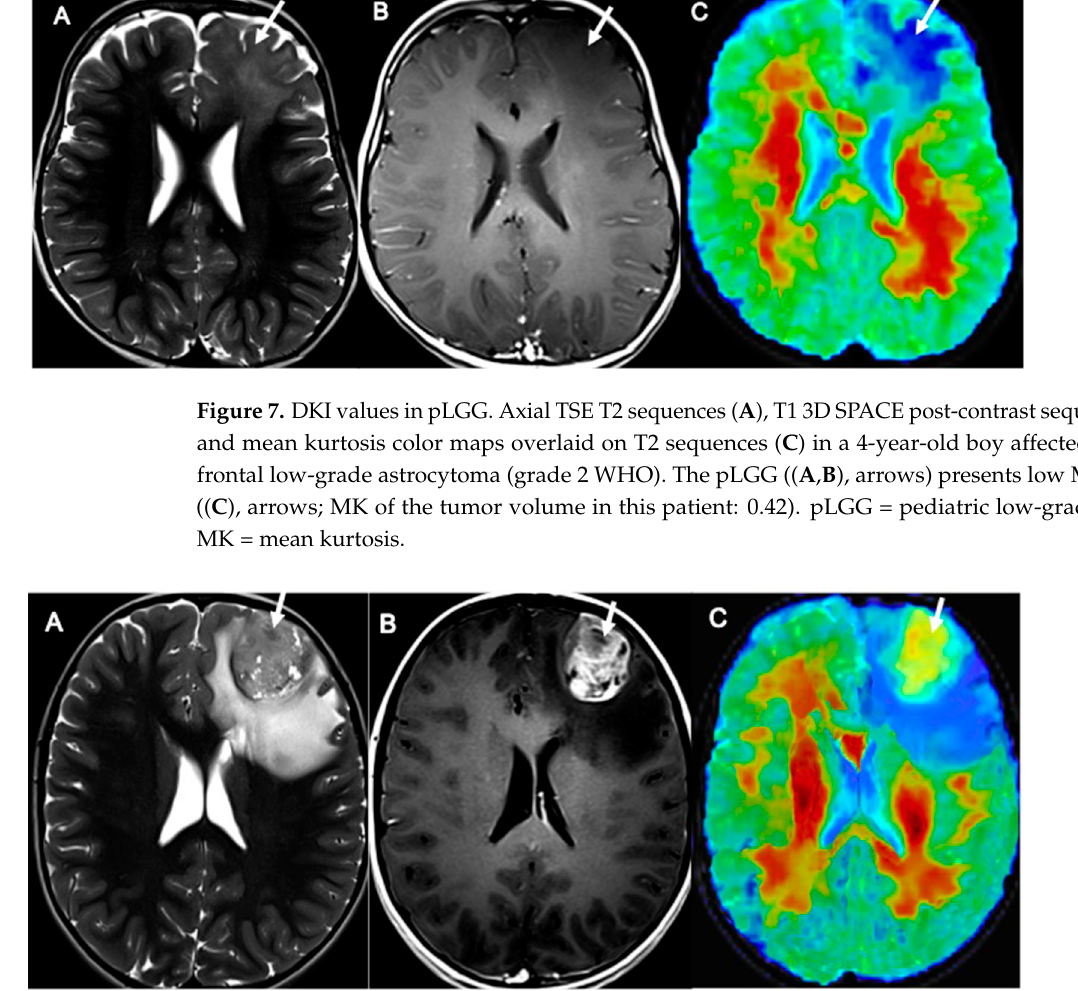
Figure 8. DKI values in pHGG. Axial TSE T2 sequences ( A ), T1 3D SPACE post-contrast sequences ( B ), and mean kurtosis color maps overlaid on T2 sequences ( C ) in a 9-year-old boy affected by a left frontal pHGG (grade 4 WHO, same patient as in Figure 1). The pHGG (( A , B ), arrows) presents high MK values (( C ), arrow; MK of the tumor volume in this patient: 0.70). pHGG: pediatric high-grade glioma; MK: mean kurtosis.